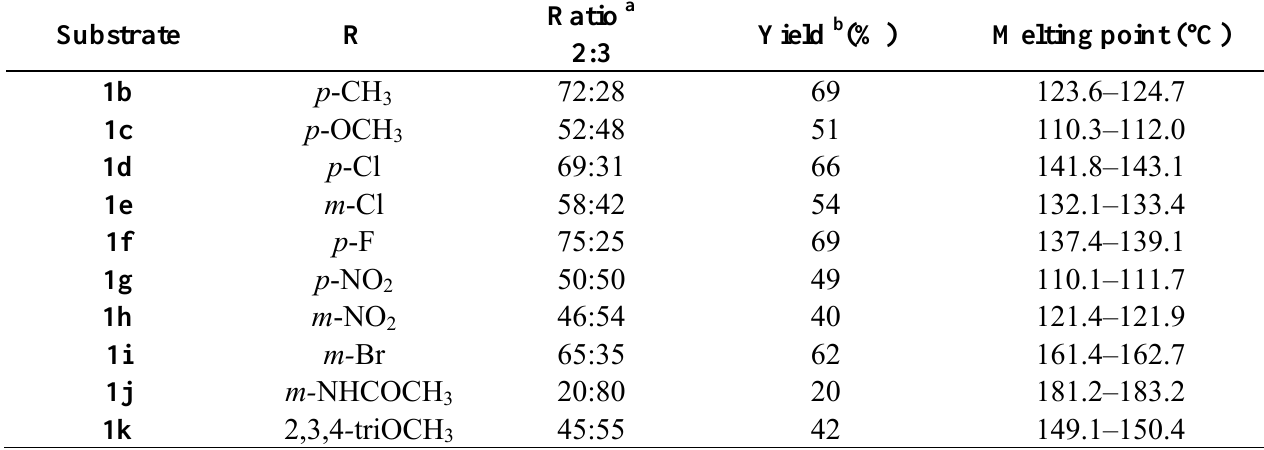
Table 6. Monohydrolysis yields for a variety of 4-aryl-4 H -pyrans 2 using 1.2 equivalents of